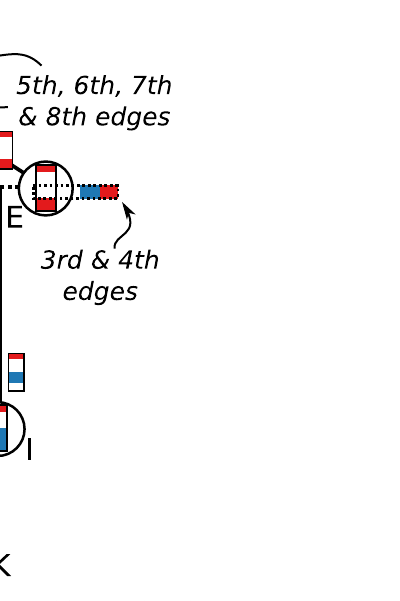
Fig 6. A depiction of each state of the simplification algorithm as it moves up through the embellished pedigree in the example of Fig 5A. Following the “paint pot” description in the text, we begin by coloring J and K’s genomes in red and blue respectively, then trace how these colors were inherited back up through the pedigree until they coalesce. To aid in this, the smaller colored chromosomes on either side of each solid arrow show the bits inherited from each of the two parental chromosomes, with genomic position 0.0 on the bottom and 1.0 at the top. Each time a red and a blue segment overlap, a coalescence occurs, two edges are output, and we stop propagating that segment. For instance, both J and K inherit from H between 0.5 and 0.9, which resulted in the first two edges of the simplified table of Fig 5C. Later, both inherit from E between 0.2 and 0.5, along the paths J-H-G-E and K-I-E respectively, resulting in the next two